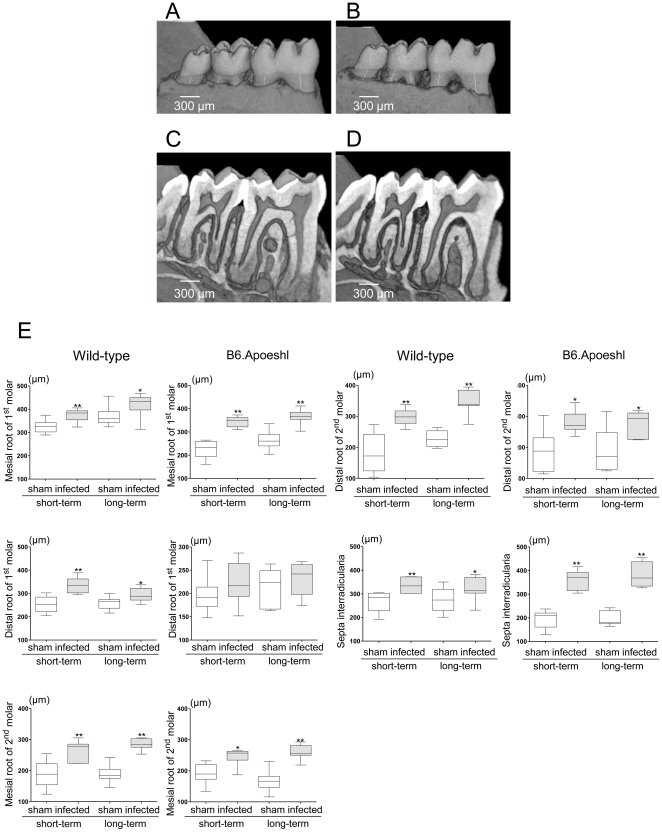
Determination of alveolar bone loss (A–D).Three-dimensional (A and B) and two-dimensional (C and D) microcomputed tomography images of representative samples from sham-infected mice (A and C) and infected mice (B and D) are presented. The infected group (A) showed an increase in the distance from the cement-enamel junction (CEJ) to the alveolar bone crest compared with the sham-infected group (B). Two-dimensional micro-CT sections for the infected group (C) but not the sham-infected group (D) showed alveolar bone loss at the bifurcation. Numerical analysis of alveolar bone loss between the control group and the infected group (E; N = 10 in each group) was performed. The distance between the cement-enamel junction and alveolar bone crest in each tooth root was determined from three-dimensional micro-CT images using image visualization software. Box plots present medians and the 25th and 75th percentiles as boxes and the 10th and 90th percentiles as whiskers. Significant differences were observed between the infected group and the sham-infected group (* P<0.01; ** P<0.001, Mann-Whitney U-test).